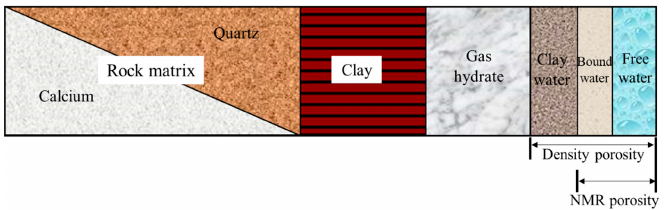
Figure 3. Model of bulk-volume rock of gas-hydrate-bearing sediment reservoirs.